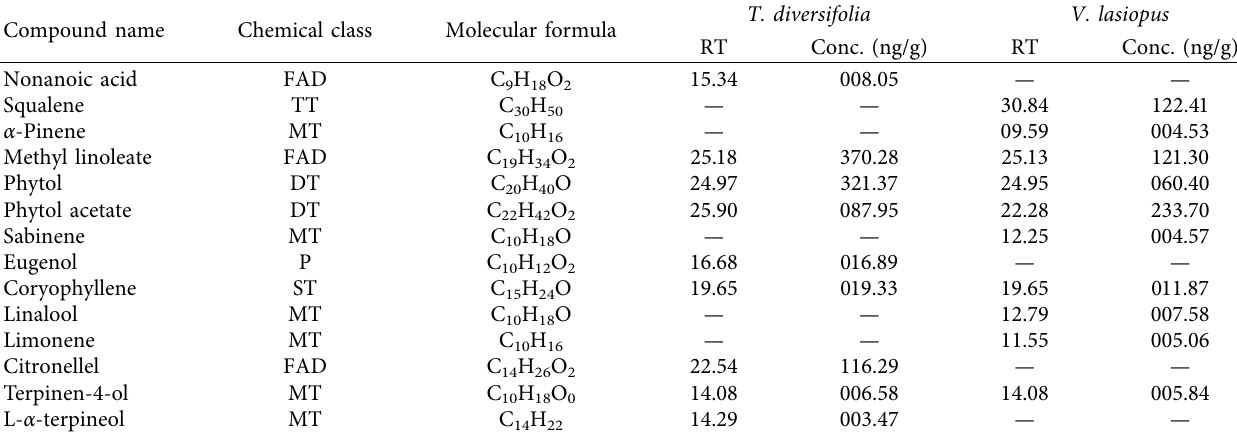
Table 3: Phytochemical analysis of insecticidal compounds in the ethyl acetate leaf extracts of T. diversifolia and V. lasiopus .